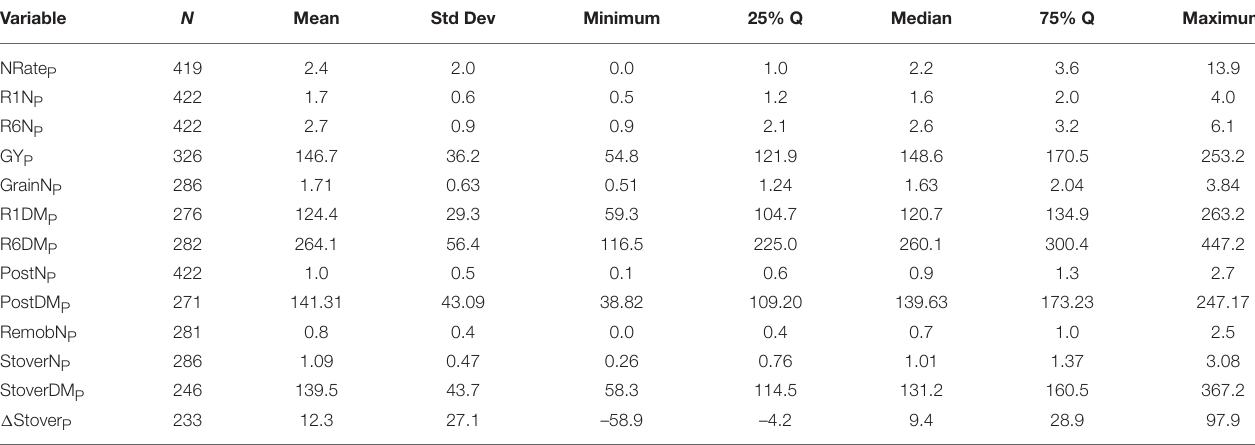
TABLE 5 | Summary statistics on a per plant basis for the New Era data set.